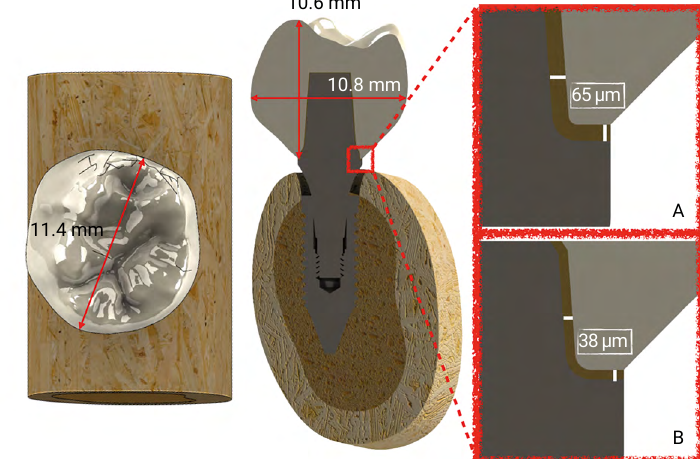
Figure 2. Occlusal and sectional schematic view showing the crown dimensions and cement thickness used in the CAD/CAM (A) and heat-pressed milled wax-pattern (B) groups.